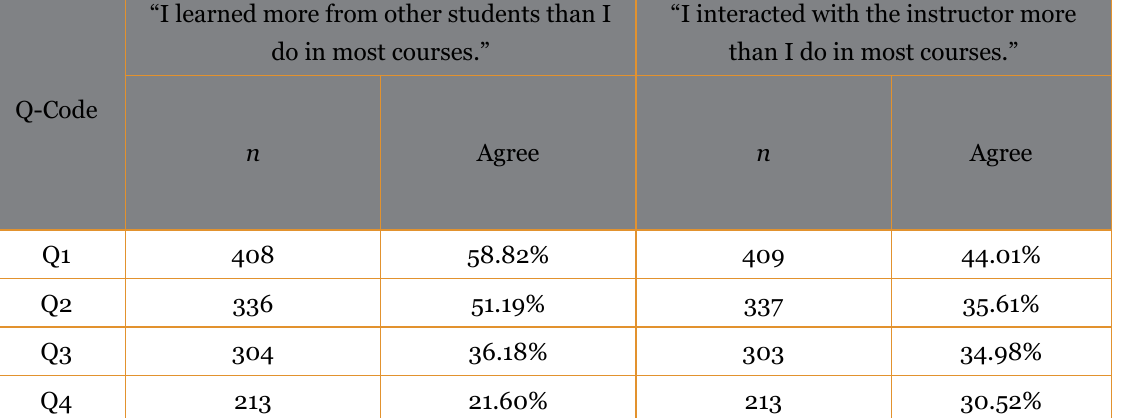
Agreement for Learning from Other Students, Interacting with the Instructor “I learned more from other students than I “I interacted with the instructor more do in most courses.” than I do in most courses.” Q-Code n Agree n Agree